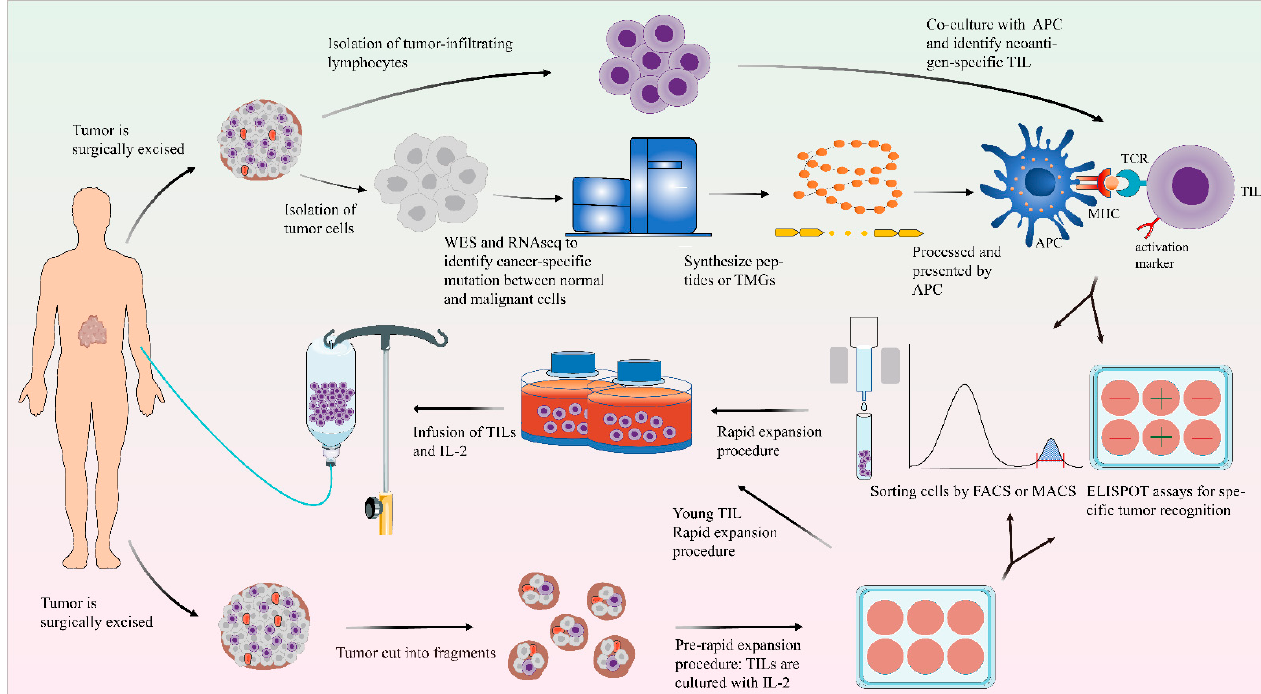
Figure 1. General scheme of the preparation of TILs. After excision, the tumor tissue is fragmented or digested into a single-cell suspension and then cultured in cell culture plates with IL-2. Using the selected TIL method, the detection of tumor reactivity is based on the production of IFN- γ by co-culturing with autologous tumor cells. In the “young” TIL method, the assays for specific tumor recognition are omitted. TILs could be enriched by FACS or MACS. TIL cultures are then expanded to treatment levels by REP. These TILs are then infused back into the lymphodepleted patient. On the other side, the tumor cells and normal cells undergo WES and RNA-seq to identify mutations. Based on this information, TMG or peptides are synthesized. These TMG or peptides are then processed by autologous APC and presented to T cells which are co-cultured with APCs. The recognition of neoantigen-specific T cells depends on IFN- γ ELISPOT assays, and these identified T cells with activated surface markers (such as CD137) can be purified by